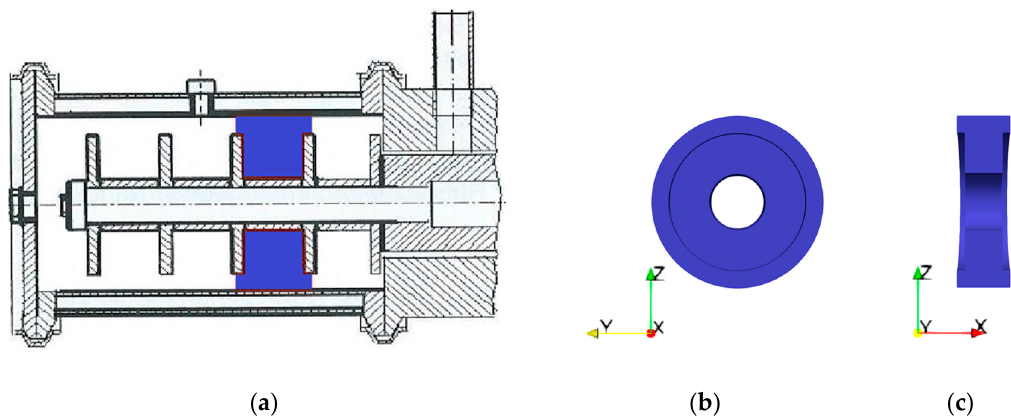
Figure 1. Simulated geometry: ( a ) simulation area shown in a horizontal stirred media mill (adapted from [9]); ( b ) simulation area in the axial direction; ( c ) axially cut side view.